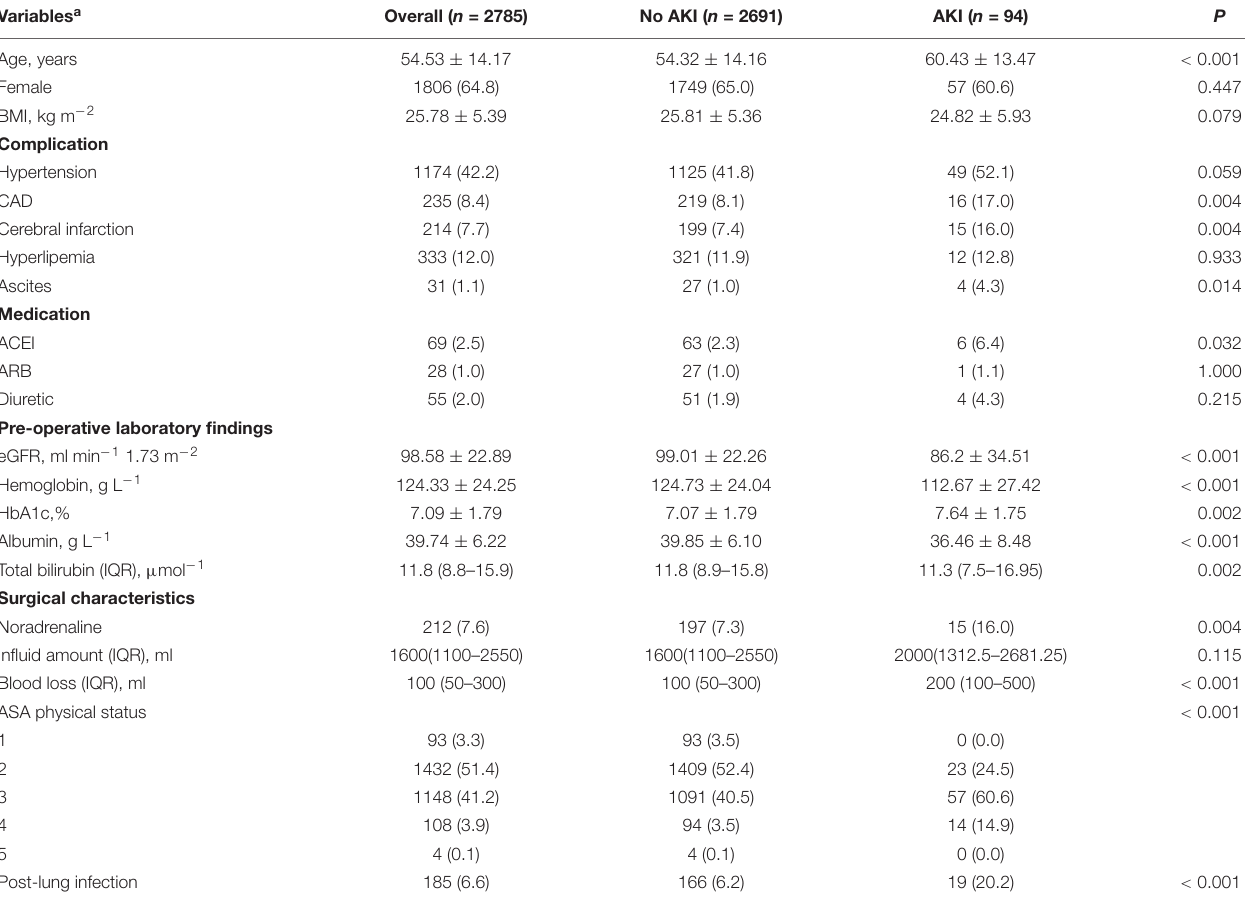
TABLE 1 | Baseline characteristics of the